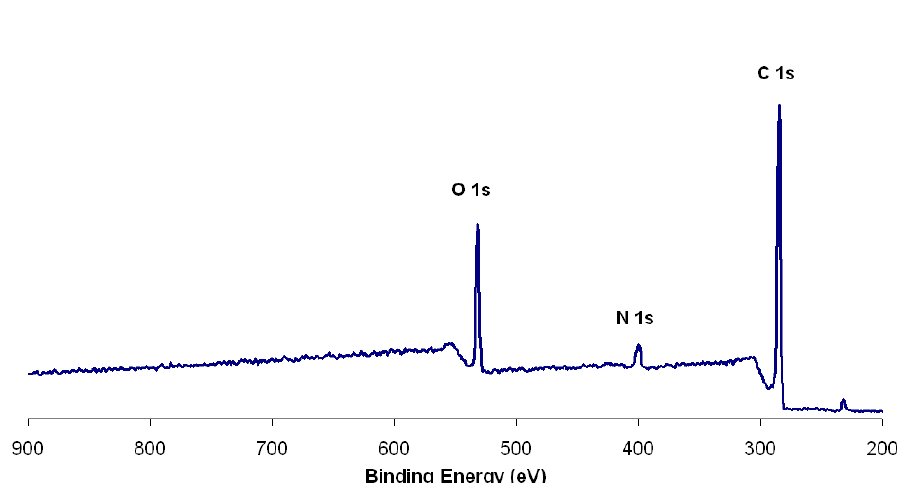
Figure 6. XPS survey spectra showing the data gathered for the PANI/PVB/PS3 composite film over the full range of binding energies